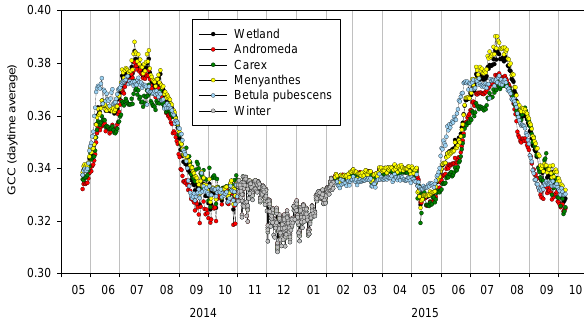
Figure 5. Mean daytime (10:00–14:00, local winter time) GCC of different regions of interest (vegetation types) during the measure- ment period of May 2014 to October 2015. Wetland refers to com- bined ROI shown in Fig. 5b. The grey circles indicate the wintertime data that are influenced by an insufficient light